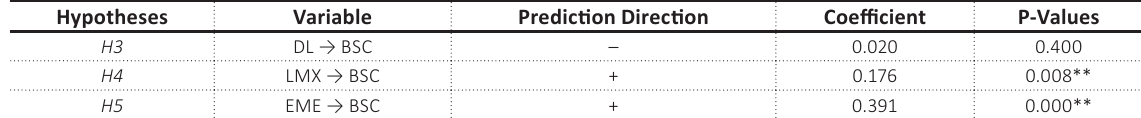
Source: SmartPLS 3 processing